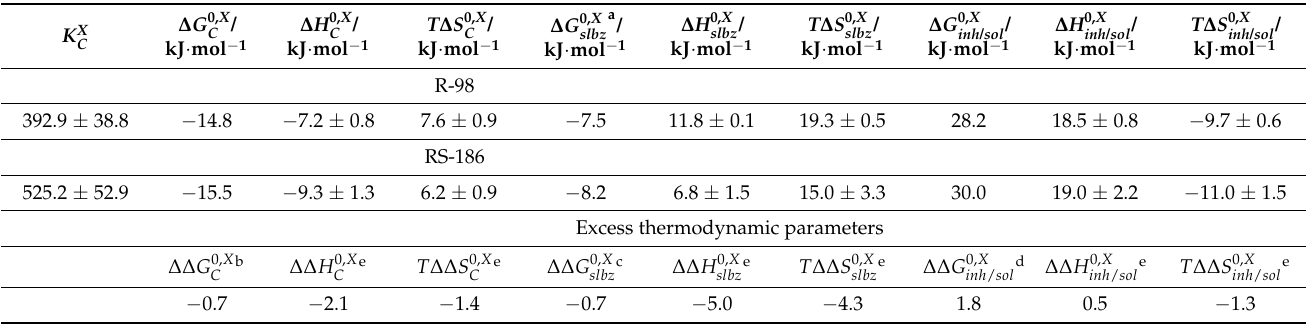
Table 3. Complexation constant ( K X ), thermodynamic parameters of inclusion complex forma- C tion of the studied compounds with cyclodextrins: change of the standard Gibbs energy ( ∆ G 0, X ), C enthalpy ( ∆ H 0, X ), and entropy ( T ∆ S 0, X ); solubilization thermodynamic functions: change of the C C standard Gibbs energy ( ∆ G 0, X ), enthalpy ( ∆ H 0, X ), and entropy ( T ∆ S 0, X ); and inherent solubility slbz slbz slbz thermodynamic parameters: in buffer solution pH 2.0 at 298.15 K and pressure p = 100 kPa (mole fraction